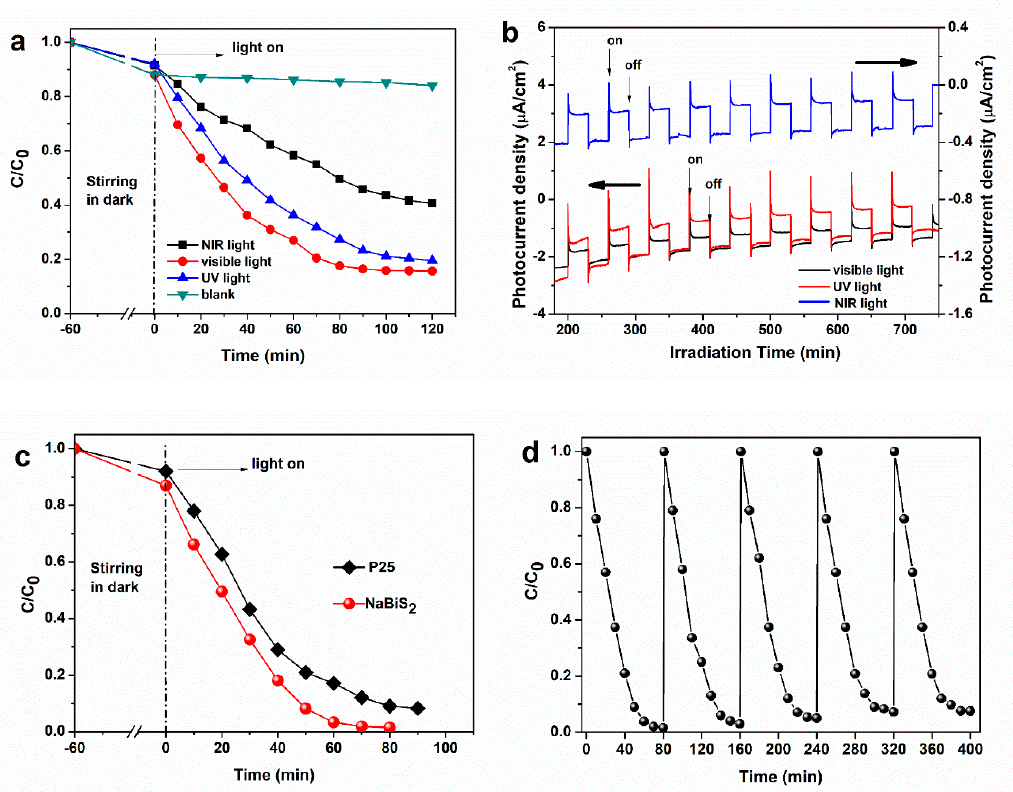
Figure 5. Photocatalytic activity and photocurrent measurement. ( a ) Degradation of MB with the irradiation of UV, visible and NIR light; ( b ) photocurrent density under UV, visible and NIR light; ( c ) degradation of MB with the full spectrum, compared with P25 without any other additive; (d) cycle runs under the full spectrum.